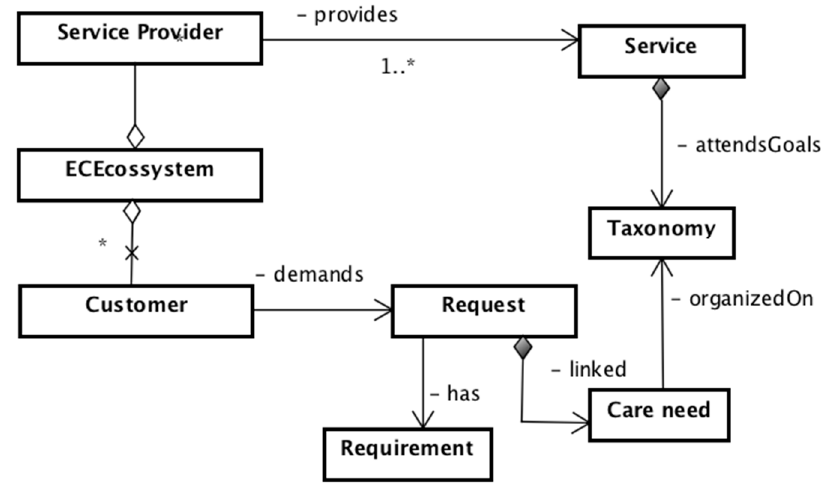
Figure 4. The main elements of ECE and their relationships.